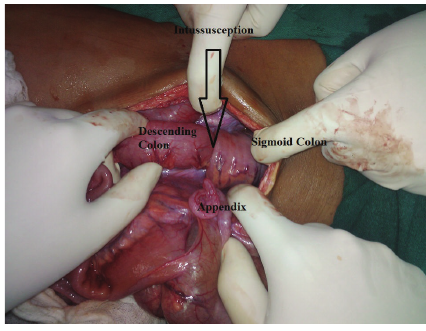
Figure 2: Photograph showing the colocolic intussusception.